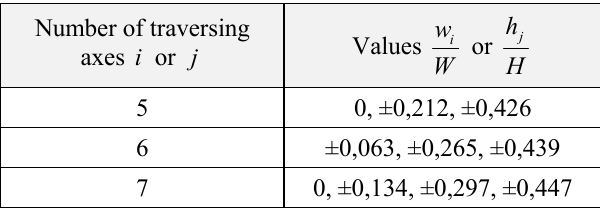
Fig. 6. Velocity distribution along the axis h